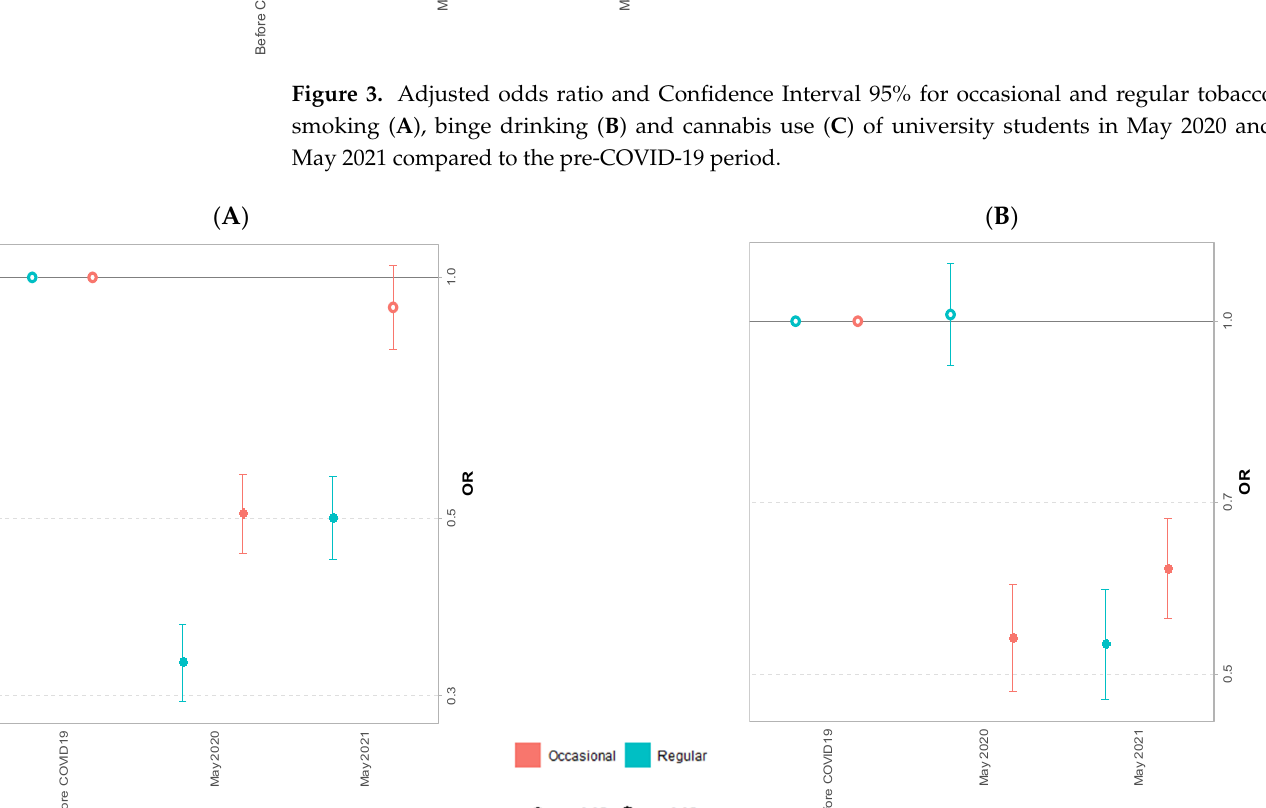
Figure 3. Adjusted odds ratio and Confidence Interval 95% for occasional and regular tobacco smoking ( A ), binge drinking ( B ) and cannabis use ( C ) of university students in May 2020 and May 2021 compared to the pre-COVID-19 period .